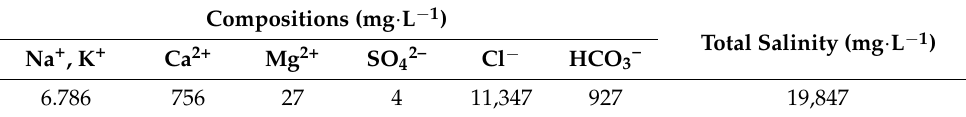
Table 2. Compositions of simulated formation water.